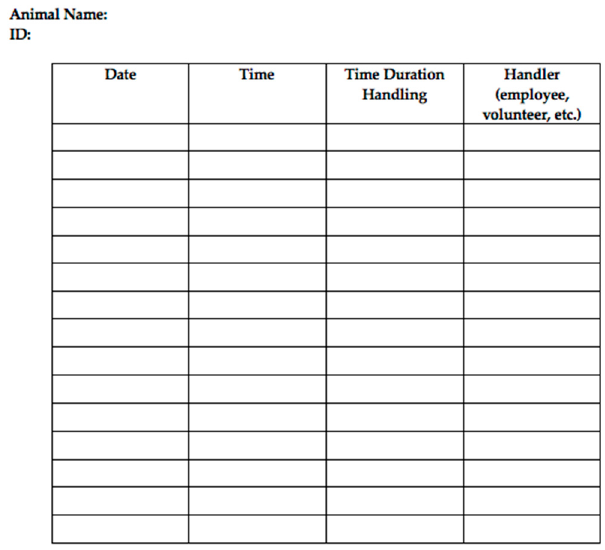
Figure A1. Abbreviated example of a cage card that would be placed on a cage for monitoring the type of handler along with frequency and duration of handling.